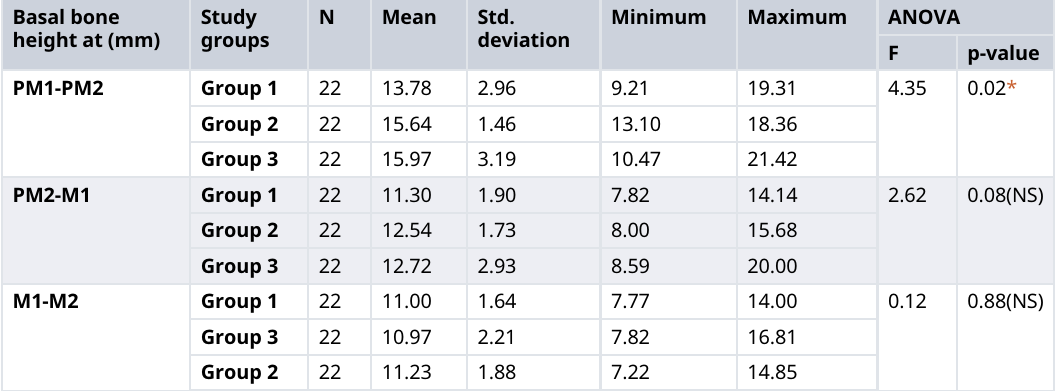
Table 2a. Comparison of Basal bone height between the study groups. Basal bone height at